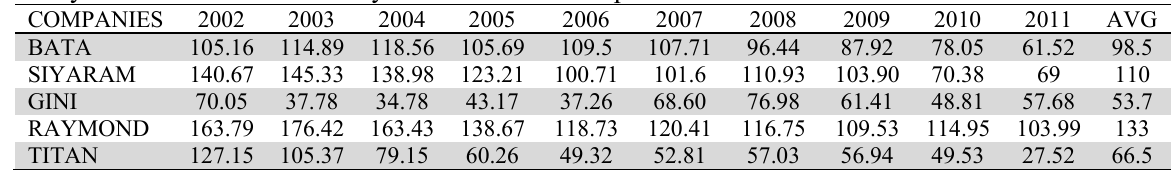
Analysis of Cash Conversion Cycle of Selected Companies of Retail sector